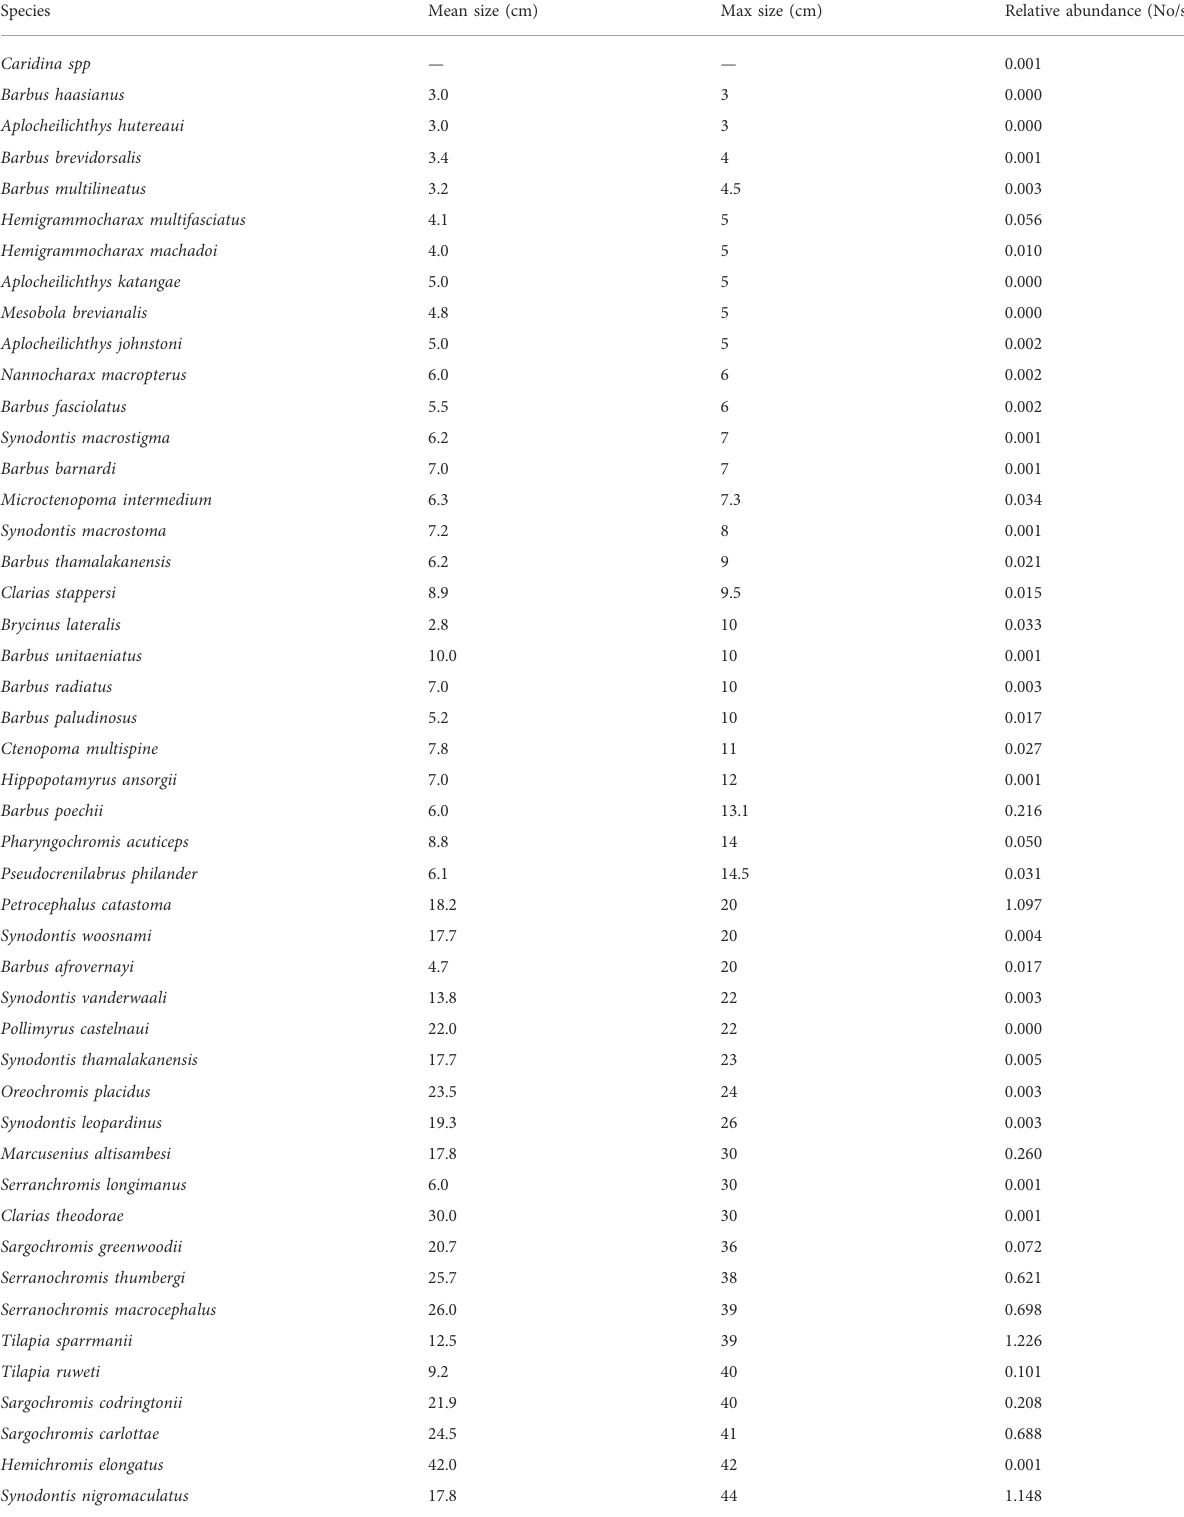
TABLE 3 List of 63 fi sh species caught in the Okavango fi shery with mean size, maximum size, and relative abundance in the catch (%). Sorted by ascending maximum size as shown in Figure 4. Species Mean size (cm) Max size (cm) Relative abundance (No/set) Caridina spp — —